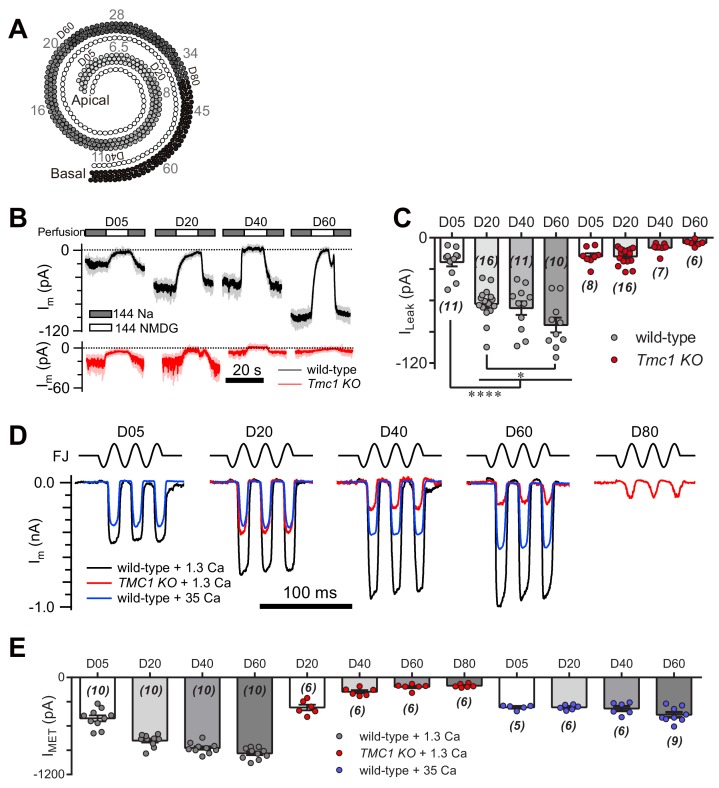
TMC1-mediated leak and MET currents in OHCs.(A) Diagram showing the tonotopic map in mouse hair cells (adapted from Figure 1B in Kim and Fettiplace, 2013), labeled with response frequencies (kHz, gray) and location (D% to apex, black). The apex and base are defined as 0 and 1, with reference to which D05, D20, D40, D60, and D80 represent distances of 0.05, 0.2, 0.4, 0.6, and 0.8. (B) Representative traces of Im recorded in OHCs at different locations along the cochlear coil, from wild-type (black) and Tmc1-knockout (red) mice. The external solution contained 1.3 mM Ca2+. The apex and base are defined as 0 and 1, with reference to which D05, D20, D40, and D60 represent distances of 0.05, 0.2, 0.4, and 0.6. (C) Quantification of location-specific ILeak from similar recordings to those in (B). Values of ILeak in wild-type OHCs (pA): D05, –23 ± 4; D20, –63 ± 4; D40, –67 ± 7; D60, –84 ± 7. ILeak values in Tmc1-knockout OHCs (pA): D05, –18 ± 3; D20, –18 ± 2; D40, –10 ± 2; D60, –5 ± 1. (D) Representative traces of location-specific MET current in wild-type OHCs when bathed in 1.3 mM or 35 mM Ca2+ and Tmc1-knockout OHCs when bathed in 1.3 mM Ca2+. A sinusoidal deflection was applied to the hair bundle by a fluid jet. (E) Quantification of location-specific macroscopic MET current. Values of IMET in wild-type OHCs in 1.3 mM Ca2+ (pA): D05, –505 ± 37 pA; D20, –780 ± 24 pA; D40, –872 ± 21 pA; D80, –939 ± 22 pA. Values of IMET in wild-type OHCs in 35 mM Ca2+ (pA): D05, –369 ± 13 pA; D20, –369 ± 13 pA; D40, –384 ± 30 pA; D60, –461 ± 31 pA. Values of IMET in Tmc1-knockout OHCs in 1.3 mM Ca2+ (pA): D20, –371 ± 35 pA; D40, –177 ± 19 pA; D60, –117 ± 15 pA; D80, –102 ± 9 pA. The holding potential was −70 mV. In (C) and (E), data are presented as mean ± SEM with N values. *p<0.05, **p<0.01, ***p<0.001, ANOVA.10.7554/eLife.47441.023Figure 8—source data 1.TMC1-mediated leak and MET currents in OHCs.